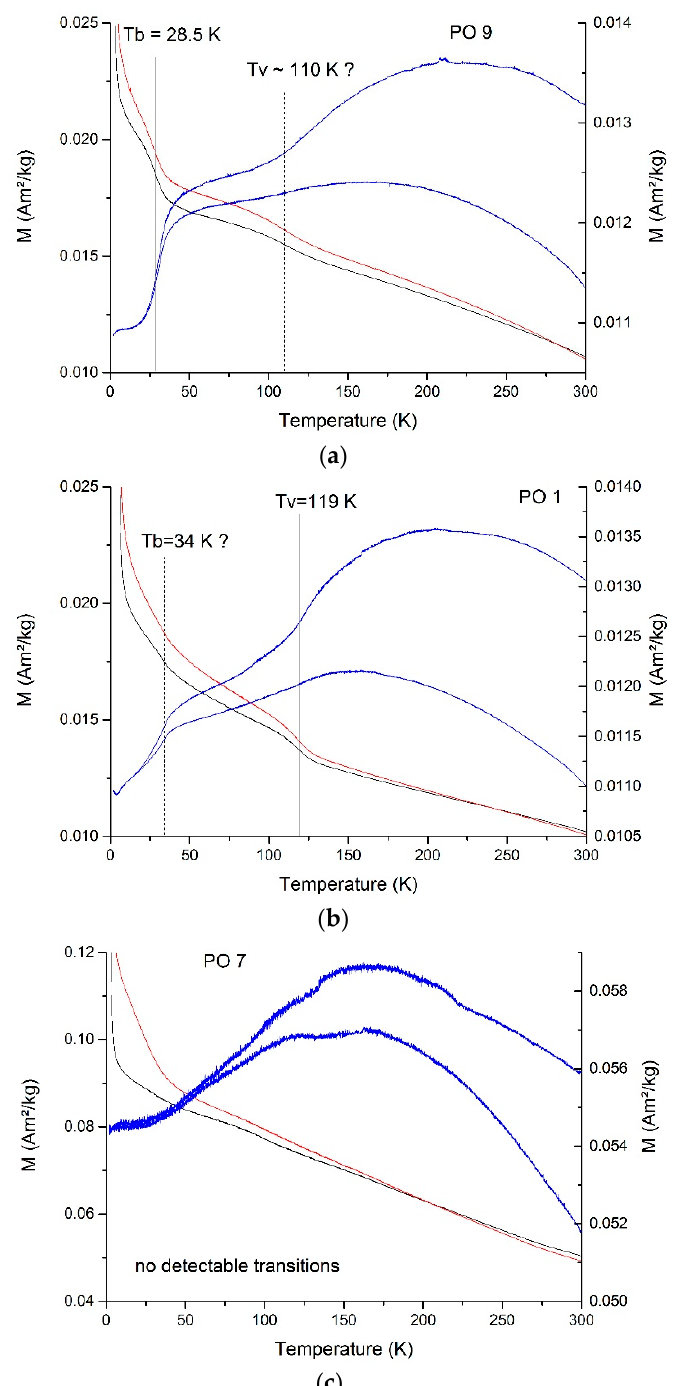
Figure 6. ( a – c ) Low-temperature properties of Popigai samples PO9, PO1, PO7. ZFC curves are shown in black, FC in red, room temperature SIRM cycle to 1.8 K in blue. ZFC and FC curves are shown above 10 K to emphasize Besnus and Verwey phase transitions. ( a ) and ( b ) show the samples with both Verwey and Besnus transitions, in variable proportion, ( c ) shows a sample with no detectable transitions. Where appropriate, transition temperatures are marked by vertical lines.